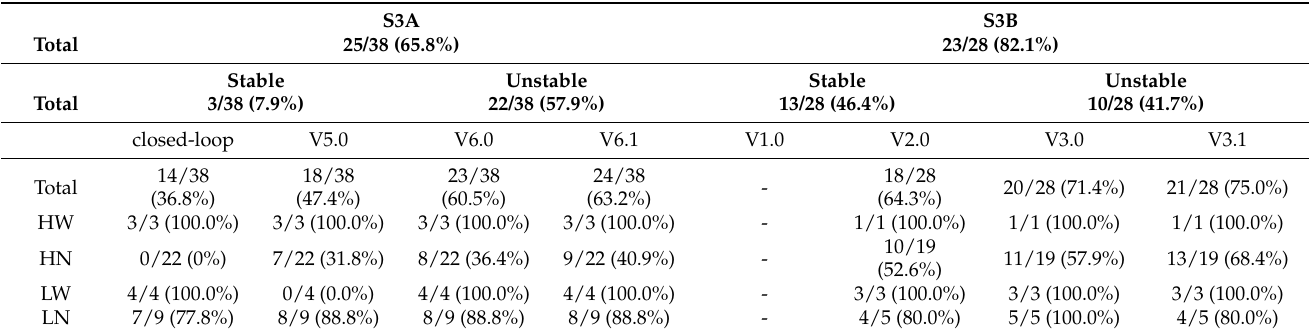
Table 1. Detection rate of Sentinel-3 in different scenarios. The numerator indicates the number of valid virtual stations (VSs), and the denominator indicates the total number of VSs for all assessments. The detection result rate is shown in parentheses. The HW, LW, NH, and LN represent VSs in high elevation and wide river, low elevation and wide river, high elevation and narrow river, and low elevation and narrow river, respectively. S3A S3B Total 25/38 (65.8%) 23/28